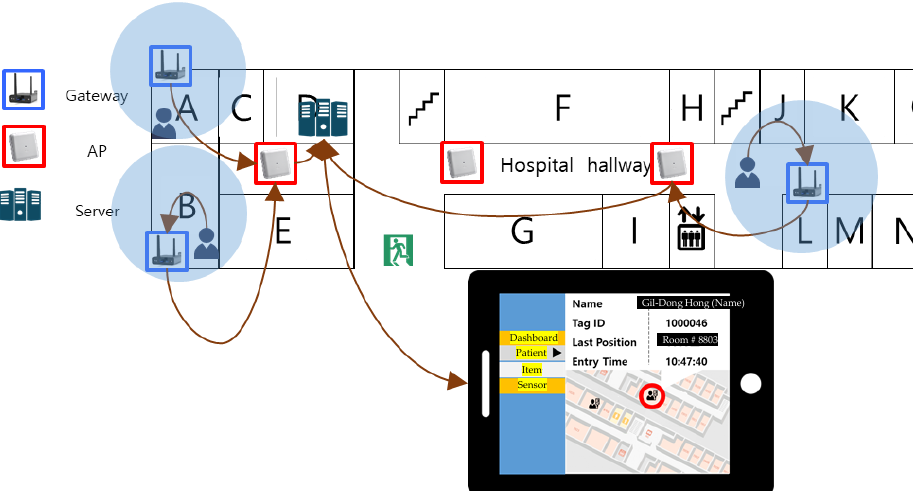
Figure 8. Dashboard Monitoring System.